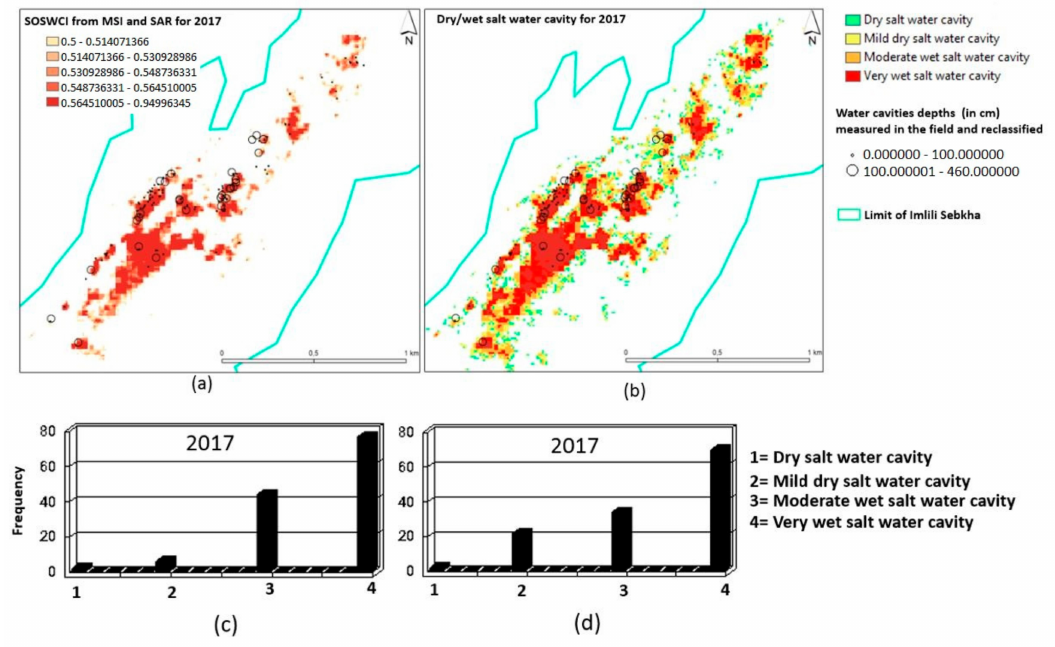
Figure 10. ( a ) The Sar / Optic Saltwater Cavity Index (SOSWCI) signal reclassified into five classes from 2017 versus the depth of saltwater cavities measured in the field and reclassified into two classes; ( b ) dry / wet states of saltwater cavities for 2017, wet / dry states statistics of saltwater cavities; ( c ) data extracted from the classified SOSWCI for 2017; ( d ) data measured in the field for the same year and reclassified into four